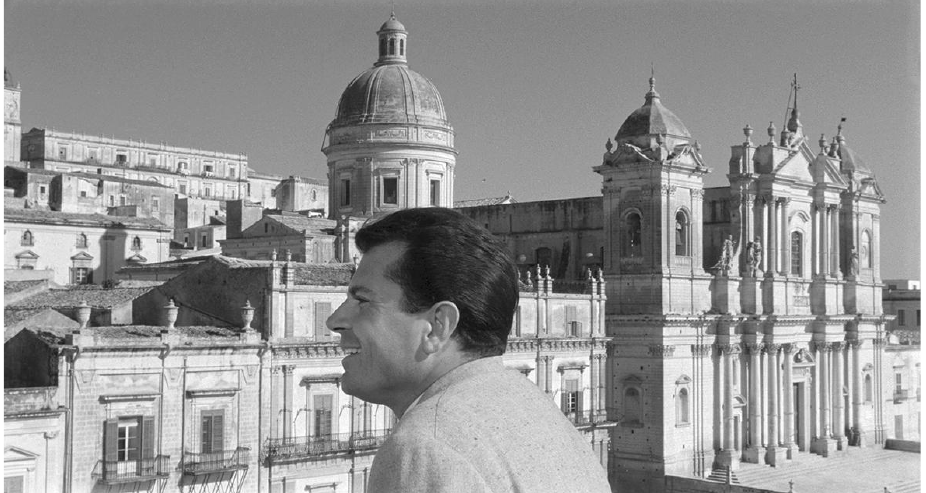
Figure 14 Architect, Sandro in L'avventura